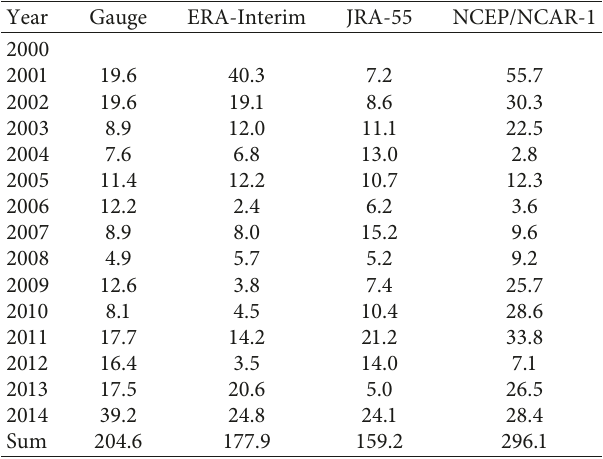
Table 7: The migration distance (km) of precipitation centroid of gauge and precipitation products. Year Gauge